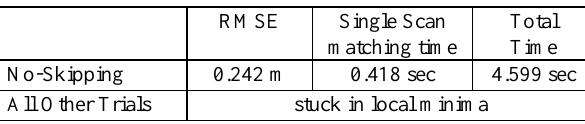
Table 3. Hector SLAM Performances (First Experiment)